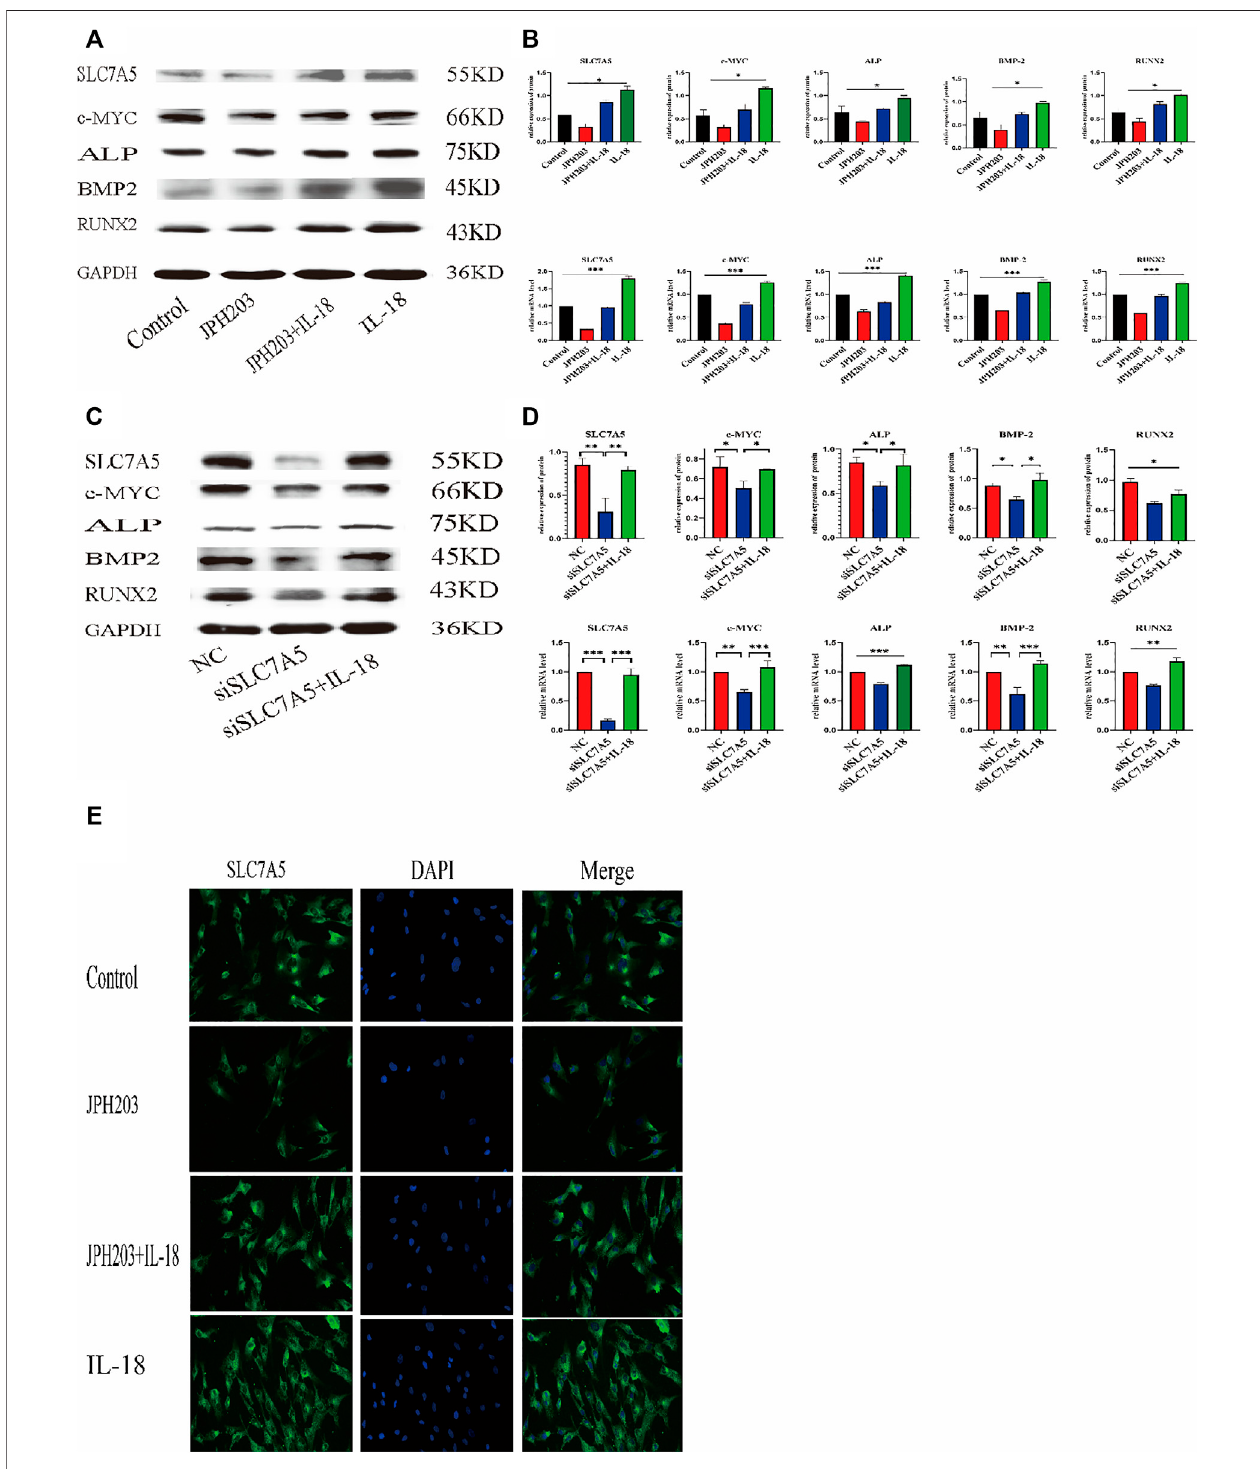
FIGURE5| Inhibition ofSLC7A5reduces thebone-formingabilityofhBMSCsinducedbyIL-18.ThecellsweretreatedwithJPH203 (5 μ M)for48 h, andthen with 100 ng/ml IL-18 for 12 h western blotting and q-PCR experiments were conducted to evaluate the expression of osteoblast-speci fi c markers, as well as SLC7A5 and c-MYC mRNA; GAPDH was used as an internal control (A, B) . Cells were transfected for 48 h and then treated with 100 ng/ml IL-18 for 12 h, mRNA levels of SLC7A5, c-MYC and osteoblast-speci fi c factors were quantied by qRT-PCR ,Cells were transfected for 72 h and then treated with 100 ng/ml IL-18 for 12 h and then westernblottingexperimentswereconductedtoevaluatetheexpression ofosteoblast-speci fi cfactors, aswellasSLC7A5andc-MYC; GAPDHwasusedasaninternal control (C, D) .Cells weretreated with JPH203 (5 μ M) and IL-18 (100 ng/ml) for 48 h, and the protein levels ofSLC7A5 wereassessed byimmuno fl uorescence (E) . Data expressed as the mean ± standard deviation (SD). Experiments were repeated three times. Scale bars: 200 μ m for F, G. * p < 0.05, ** p < 0.01, *** p < 0.001 (multiple comparisons use one-way ANOVA with a subsequent Bonferroni post-hoc test). Frontiers in Cell and Developmental Biology |